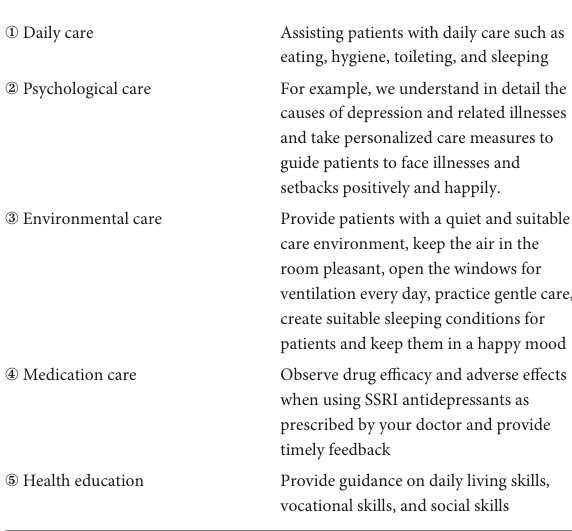
TABLE 1 Content of conventional